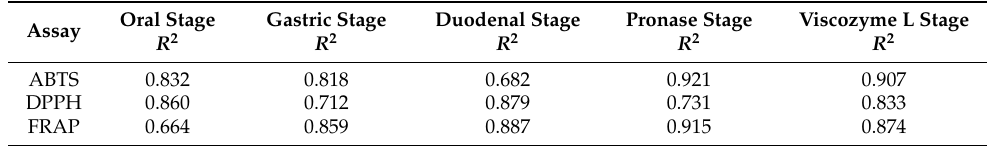
Table 5. Correlation between TPC and antioxidant activity data. The correlation coefficients were calculated Pearson’s